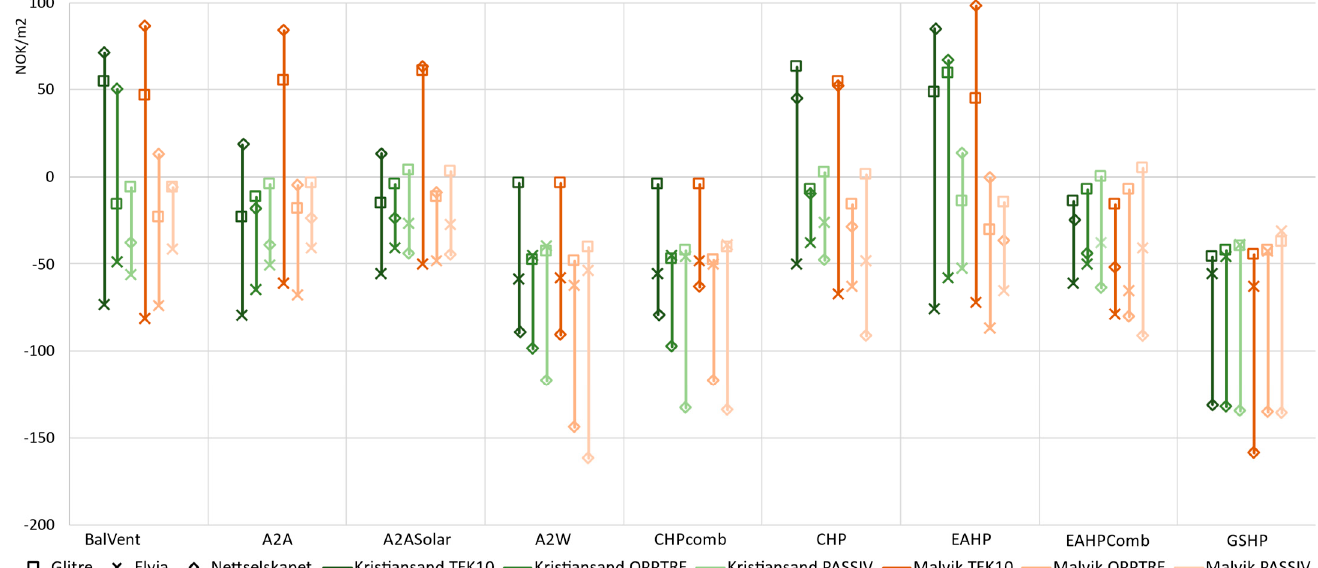
Figure 11. Total specific energy costs for Kristiansand house over 20 years for different electricity tariffs: GSHP in solid columns and A2A in shaded columns.